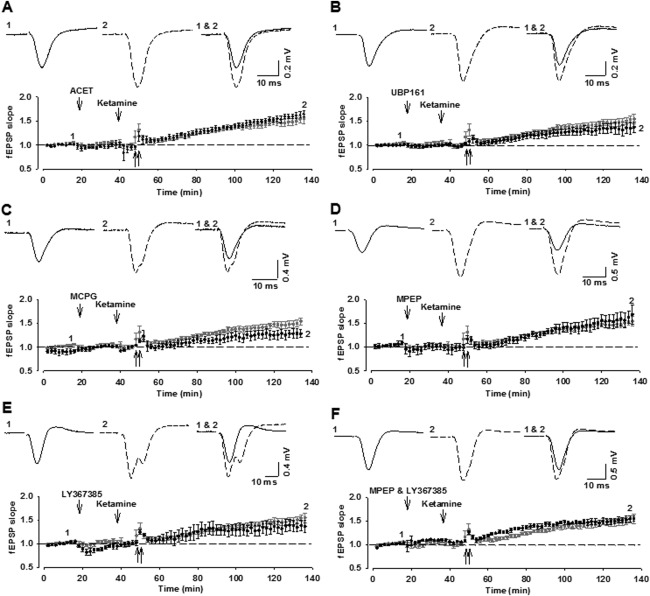
KAR or mGluR antagonists applied alone do not affect MF-LTP. (A, B) The GluK1 antagonists ACET (A: 0.1 nmol, i.h.; n = 5) or UBP161 (B, 1 nmol, i.h.; n = 5) fail to block MF-LTP. (C–F) The broad spectrum mGluR antagonist MCPG (C, 5 nmol, i.h.; n = 5), the mGlu5 receptor antagonist, MPEP (D, 1 nmol, i.h.; n = 4), the mGlu1 receptor antagonist LY367385 (E, 1 nmol, i.h.; n = 4) or the combination of LY367385 and MPEP (F, 1 and 1 nmol, i.h.; n = 4) does not block MF-LTP.